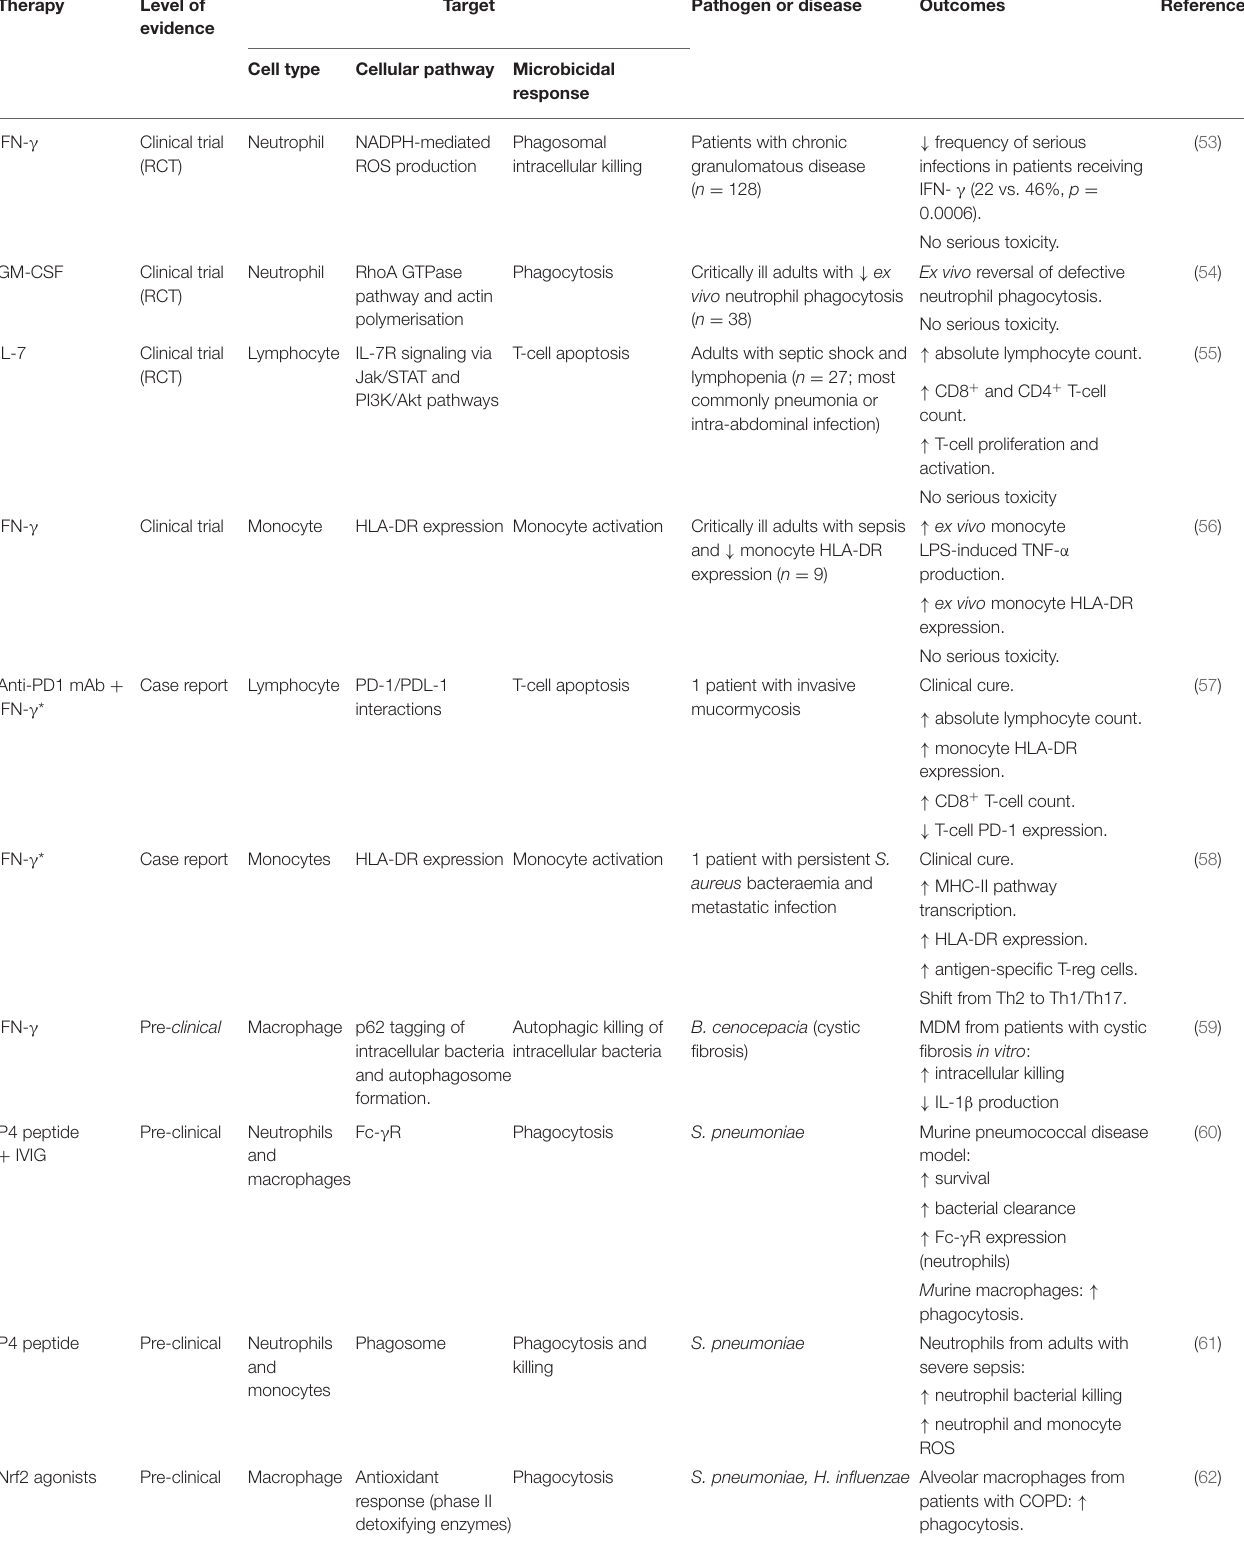
TABLE 1 | Examples of host-directed therapies in infectious diseases from clinical and pre-clinical studies.